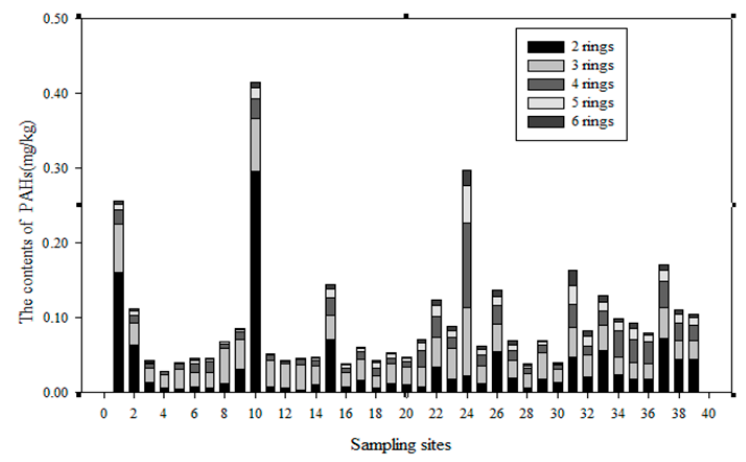
Figure 4. The contents of PAHs in Momoge Wetland soils.